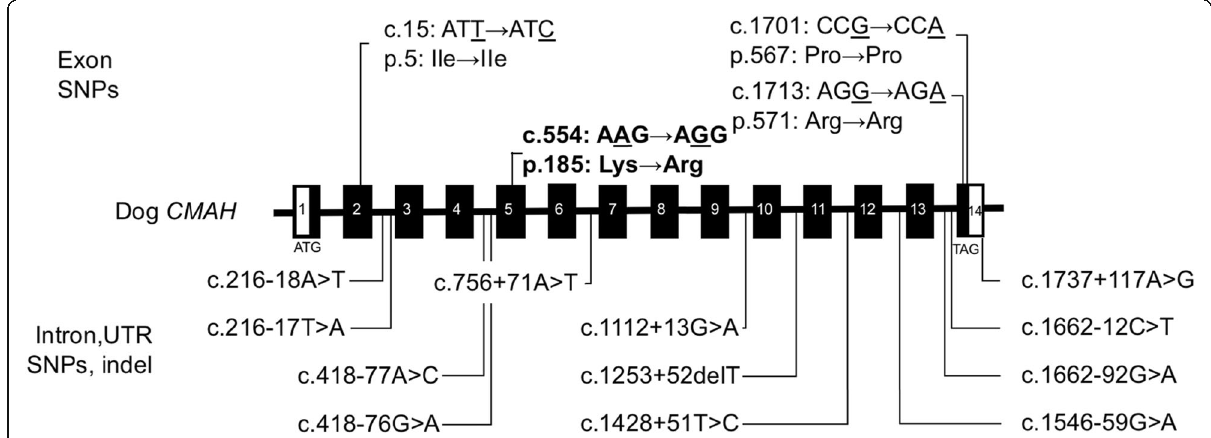
Fig. 4 Schematic representation of the DNA polymorphisms detected in canine CMAH . Genomic structure of the CMAH gene from dog was obtained by comparative analysis of mRNA sequences and whole genome shotgun sequence (Accession No. NC_006617.3, chromosome 35). □ : Exon (UTR), ■ : CDS, ▬ : Intron. The position of the identified DNA polymorphism was numbered from the A of the initiator methionine ATG codon considered to be + 1, as revealed in the exon. In introns, a positive number indicates the number of nucleotides from the previous exon, whereas a negative number indicates the number of nucleotides from the next